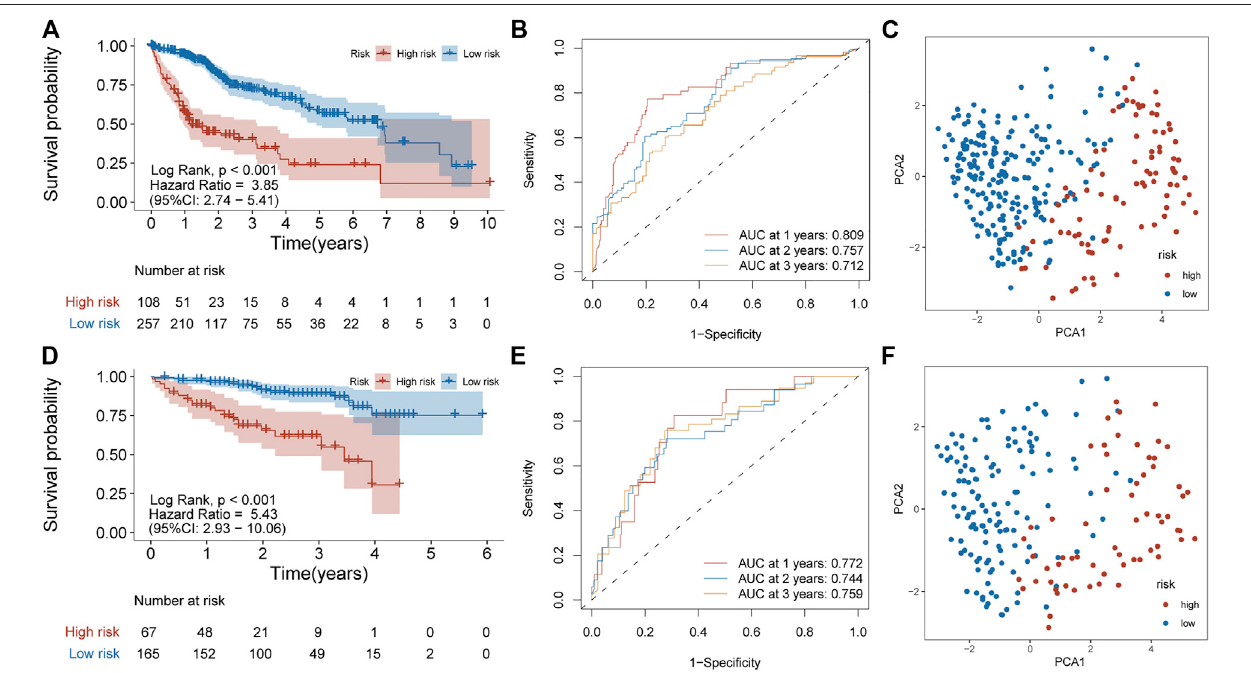
FIGURE2| PrognosticanalysisoftheIRGPssignatureinTCGAandICGCcohorts. (A) Kaplan-Meiercurveofoverallsurvivalinthehigh-andlow-riskpatientsinthe TCGA cohort. (B) ROC curve in TCGA cohort. (C) PCA plot of TCGA cohort. (D) Kaplan-Meier curve of overall survival in the high- and low-risk patients in the ICGC cohort. (E) ROC curve in ICGC cohort (F) PCA plot of ICGC cohort.